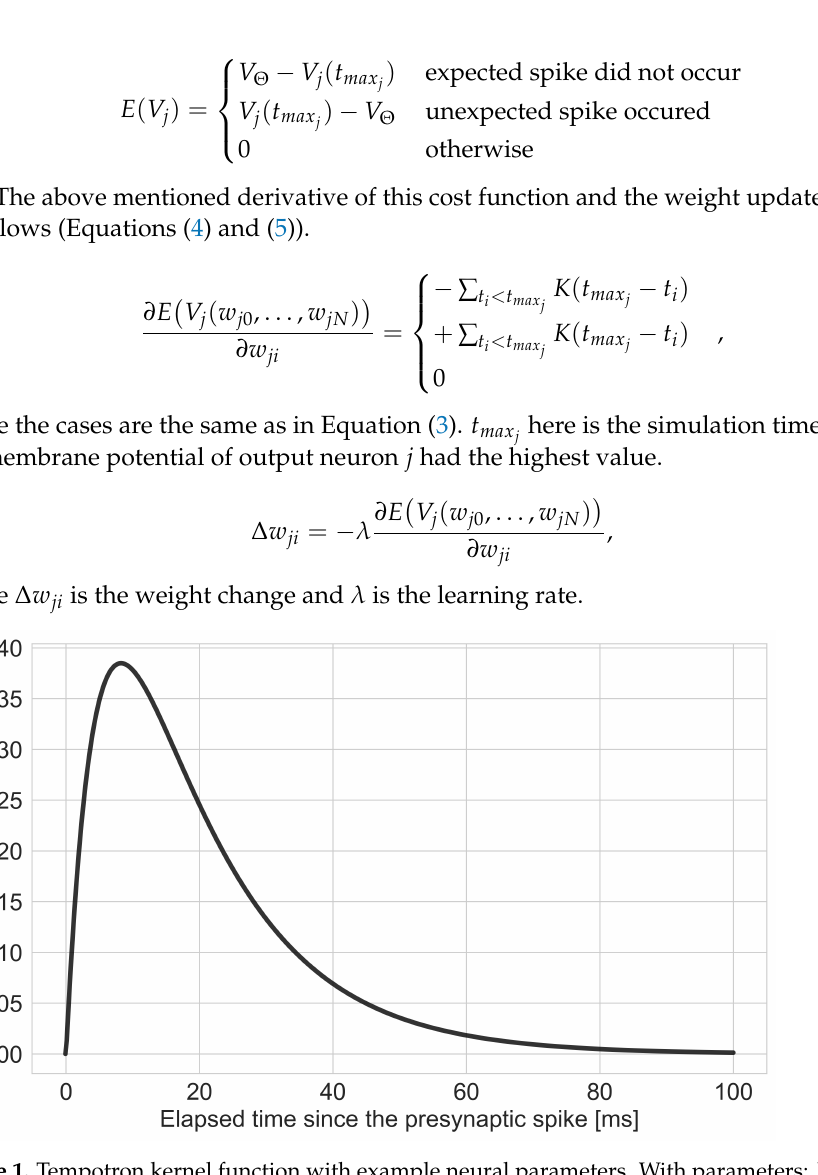
Figure 1. Tempotron kernel function with example neural parameters. With parameters: V 0 = 1 mV, τ M = 15 ms and τ S = 5